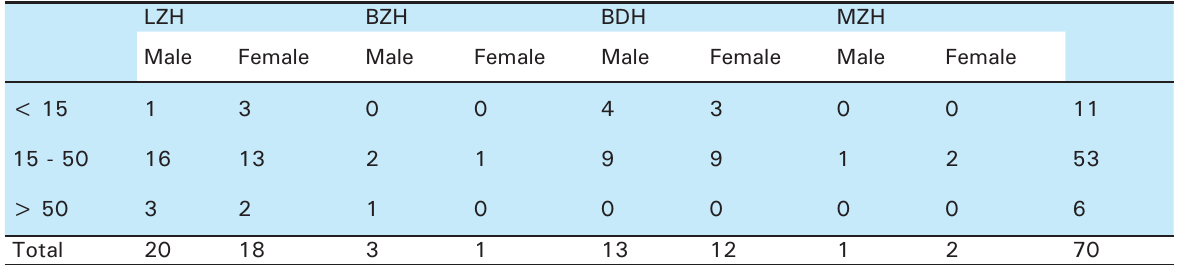
Table 2. Distribution of total positive